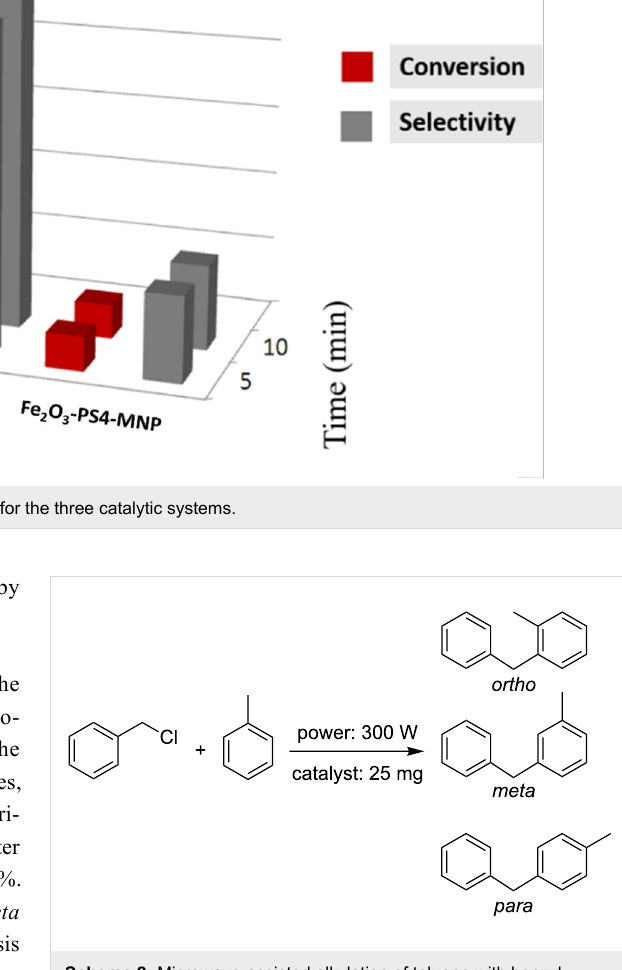
Scheme 2: Microwave-assisted alkylation of toluene with benzyl